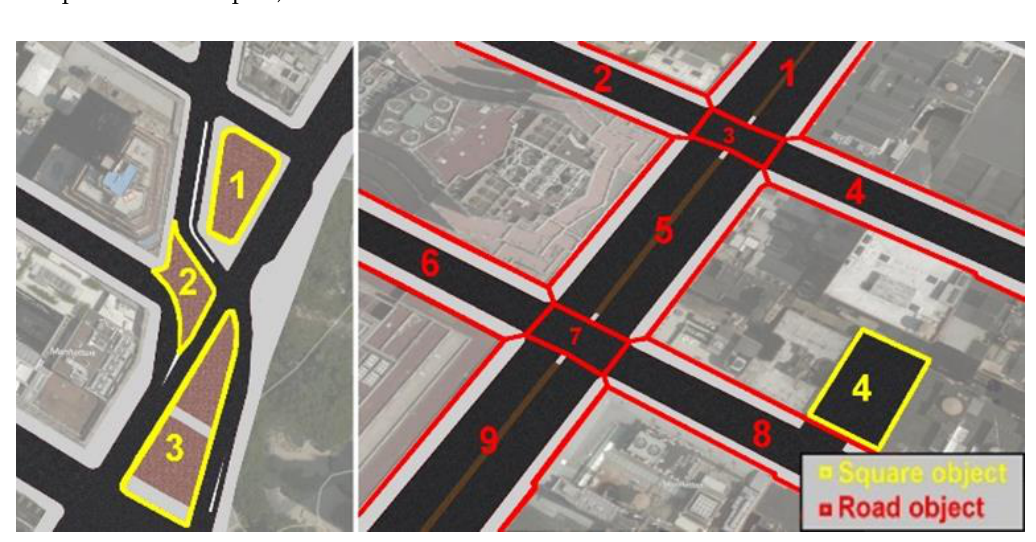
Figure 9. Affiliations between CityGML 2.0 sub- and top-level features. Figure 9. A ffi liations between CityGML 2.0 sub- and top-level features.